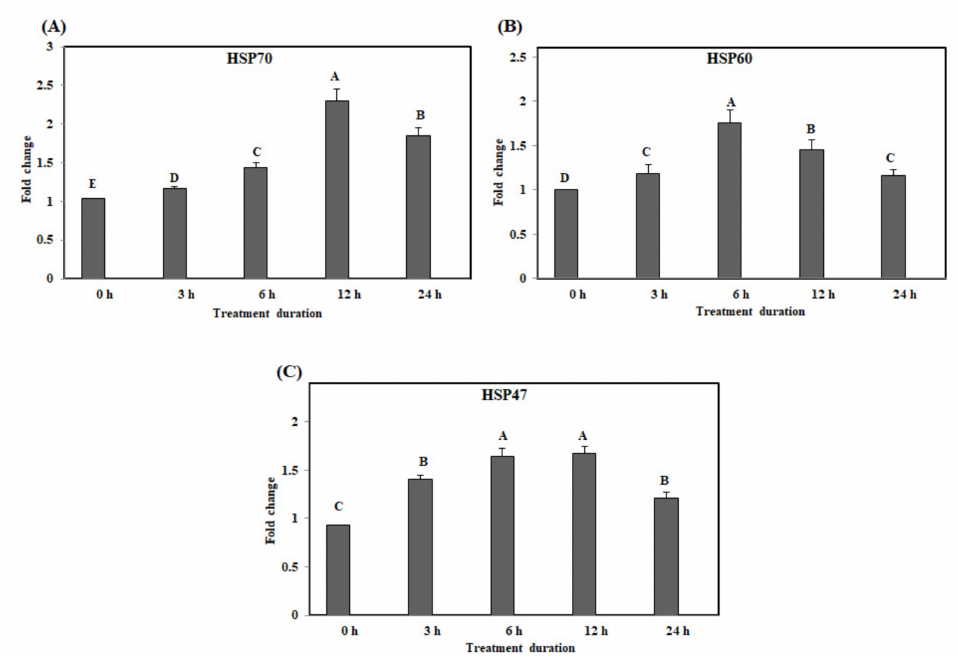
Figure 2. The mRNA expression of the heat shock proteins in the jejunum of chickens exposed to acute heat stress for di ff erent durations of time ( n = 8). The mean relative expression of HSP70 ( A ), HSP60 ( B ), and HSP47 ( C ). A–E HSP70 , HSP60 , and HSP47 in the columns with di ff erent superscript letters di ff er significantly ( p < 0.05) among the di ff erent heat exposure durations.